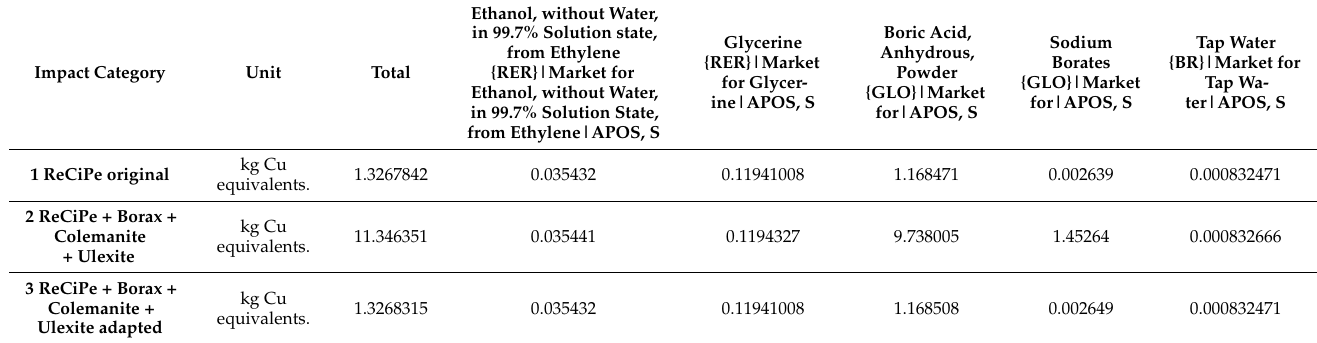
Table 11. Characterized value of the detergent expressed in kg Cu